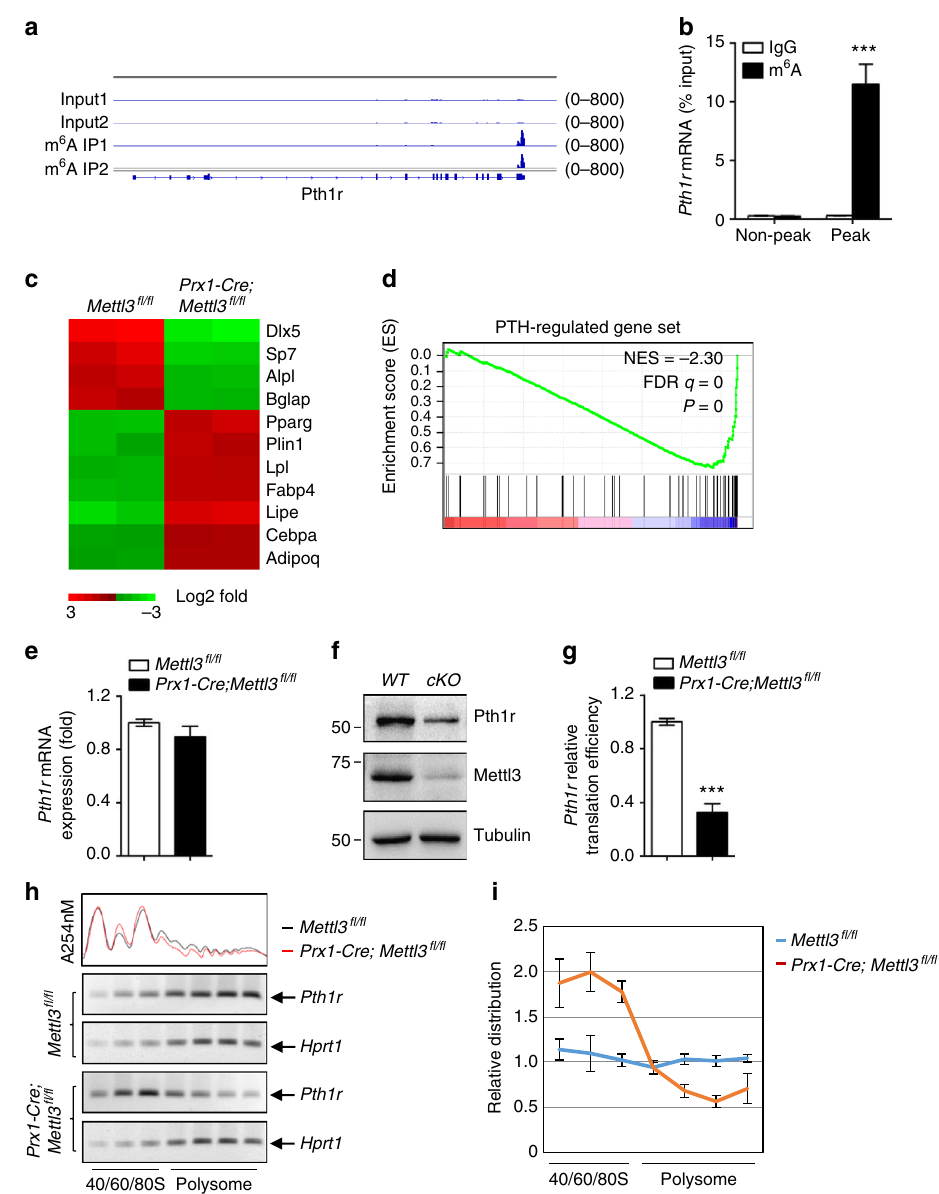
Fig. 5 Mettl3-mediated m 6 A modi fi cation in MSCs regulates Pth1r translation. a m 6 A MeRIP-Seq revealed that Pth1r has high enriched and speci fi c m 6